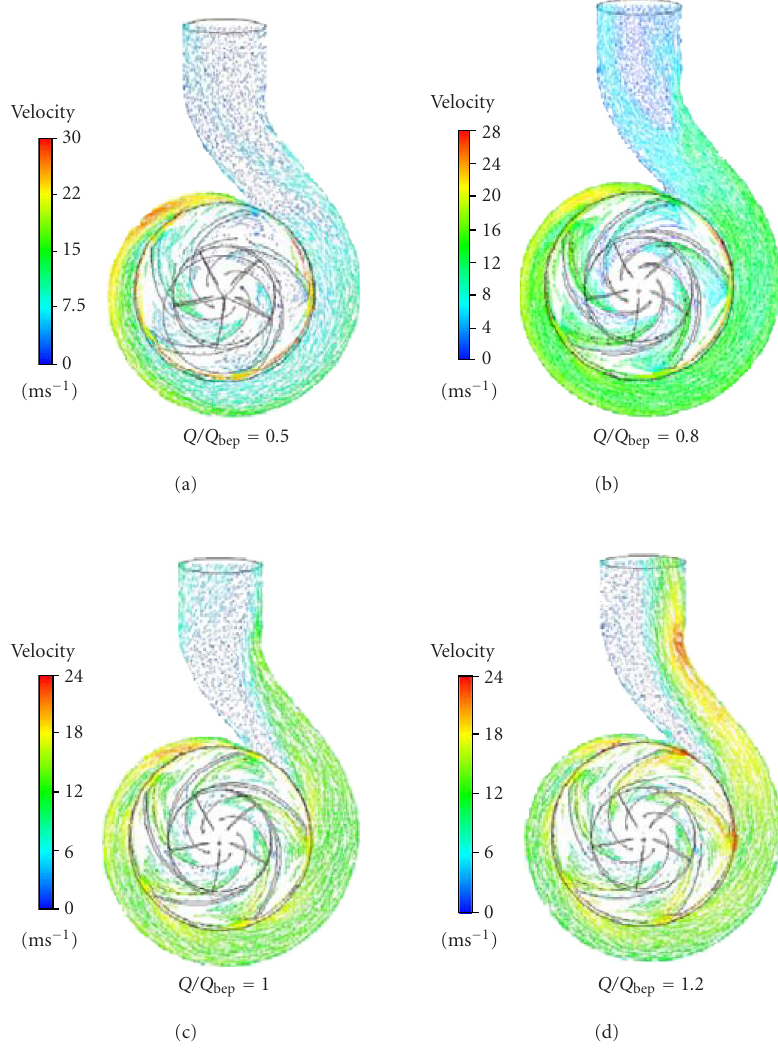
Figure 18: Velocity field at di ff erent pump